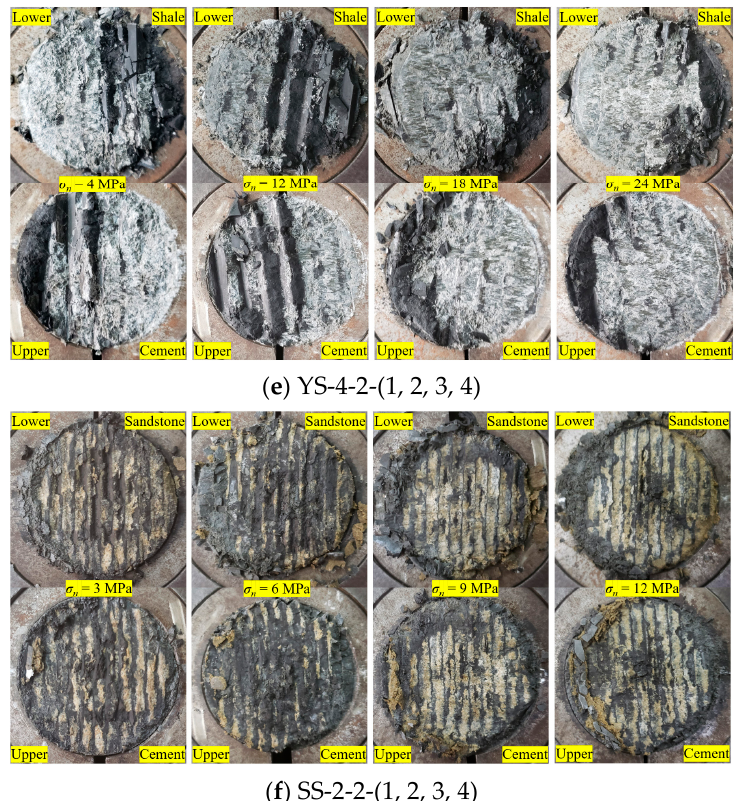
Figure 11. Morphology of shear fracture surfaces.